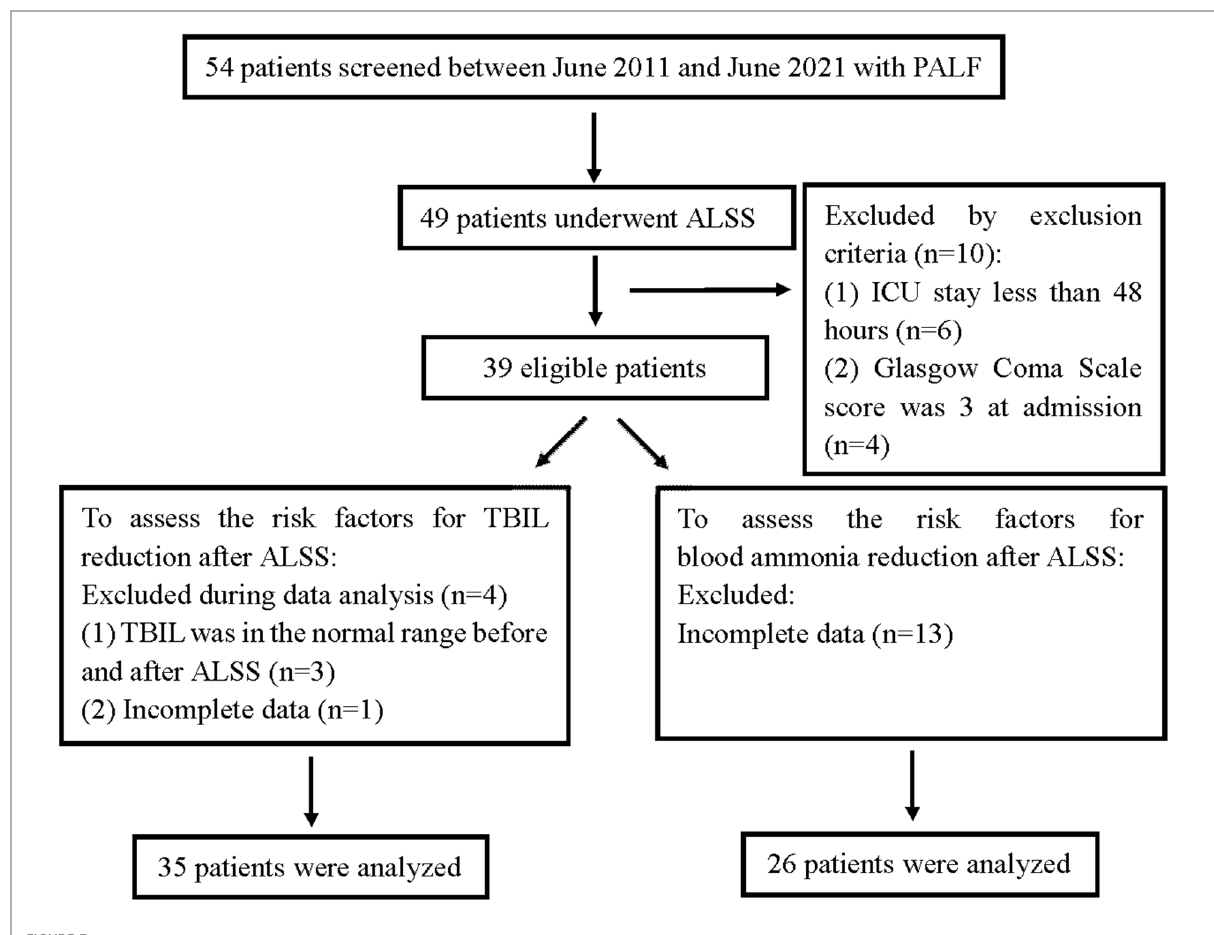
FIGURE 3 Flow chart of study